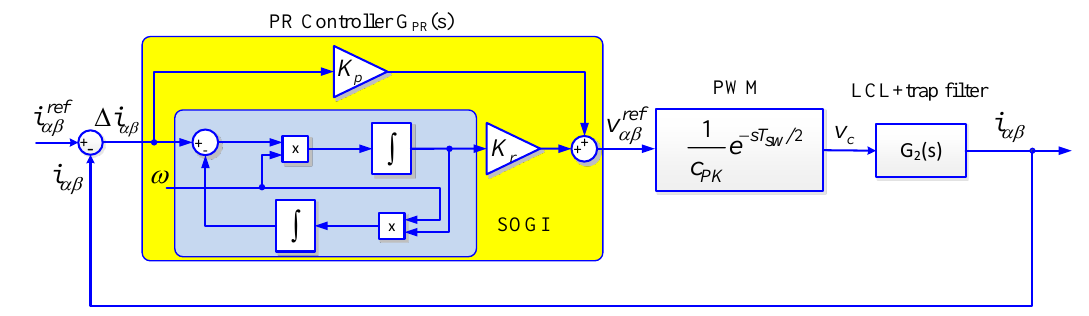
Figure 3. Modeling of the current control